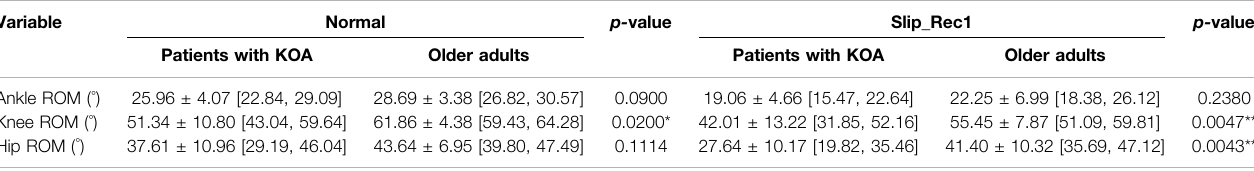
TABLE 2 | Ankle, knee, and hip range of motion (ROM) in the sagittal plane. Variable Normal p-